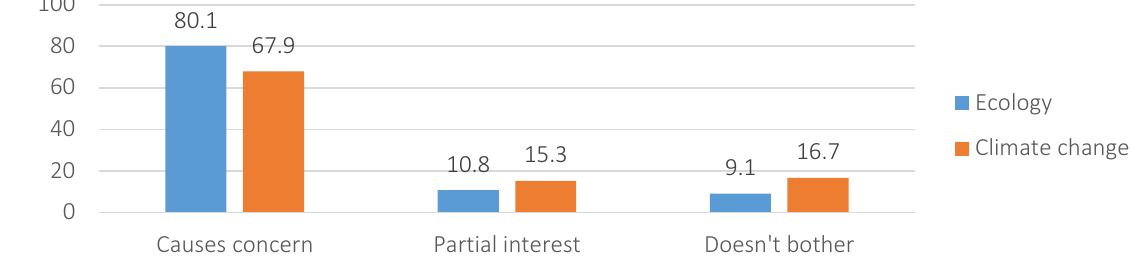
Figure 2. Attitude toward global problems of